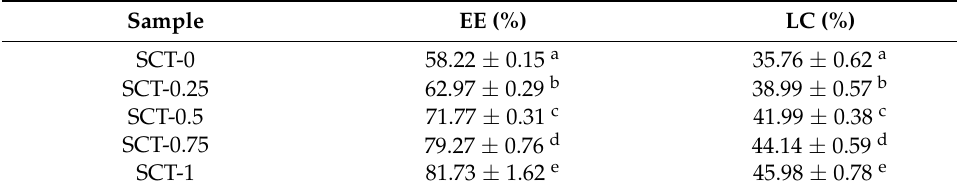
Table 1. The EE (%) and LC (%) of GLP in SCTs’